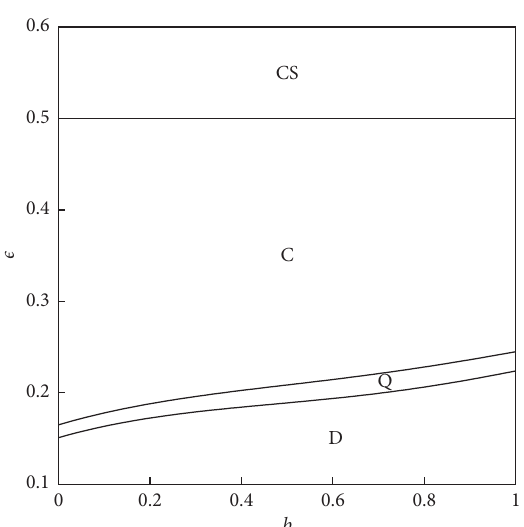
Figure 3: Phase diagram on the plane ( ε , b ) for autonomous system equations (7) and (9) with size N � 500. For each data point, the quantities p and 〈 σ 〉 are obtained by averaging over 50 realizations of random initial conditions x i [ 0 , 1 ] . Labels indicate different collective states. CS: synchronization; C: cluster states; Q: chimera states; D: desynchronization.